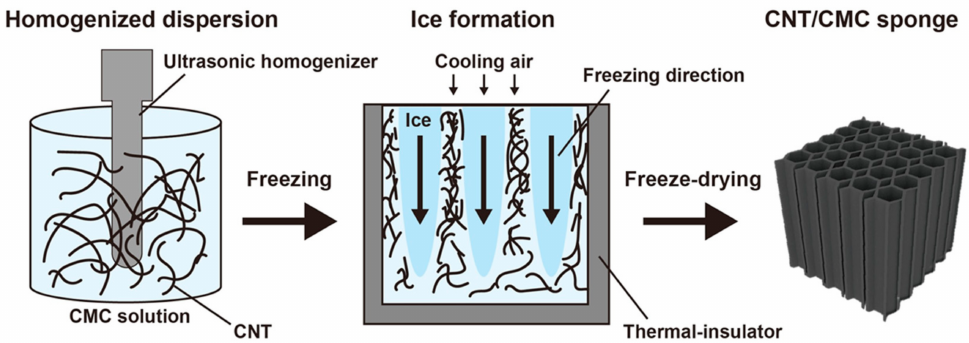
Figure 1. Schematic illustration of the preparation of a CNT/CMC